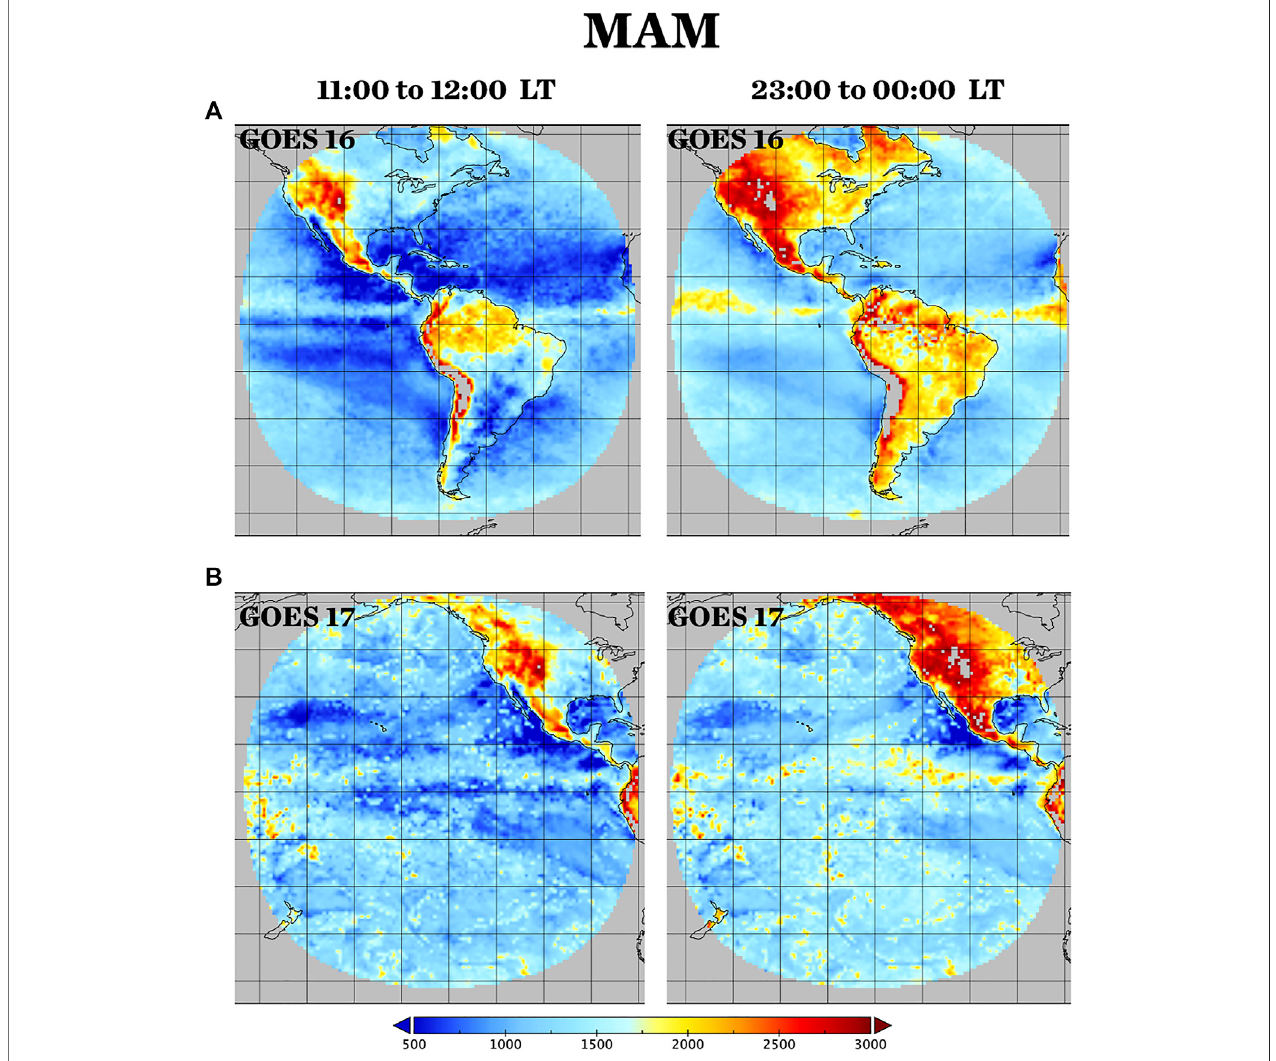
FIGURE 4 | GOES-16 (A) and GOES-17 (B) diurnal cycle of low clouds height in meters. Left column shows the cloud top height at noon local time and the right column shows the values at midnight. Cloud top height is higher during nighttime for both satellites.